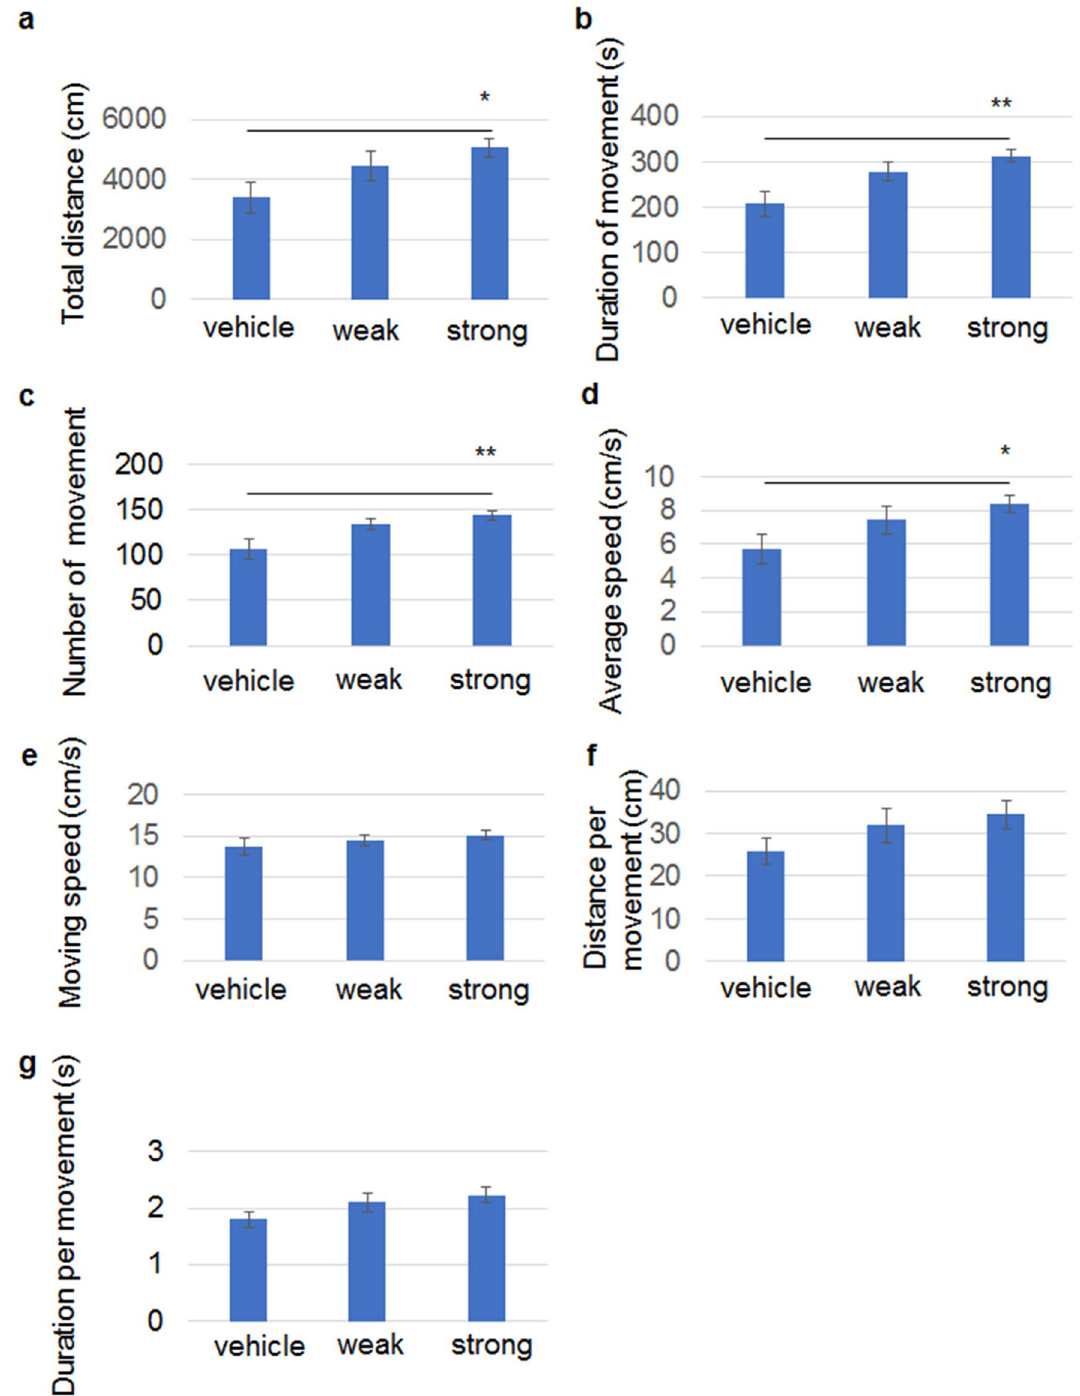
Figure 6. Strong aggregates of 13A increases spontaneous motor activities at 2 weeks of age. An open field test was conducted using 2-week-old mice that received an injection of the vehicle, weak aggregates, or strong aggregates at P2 (n = 14, each). The indices used were total walking distance ( a ), duration of movement ( b ), number of movement episode ( c ), average speed of locomotion over 10 min ( d ), moving speed ( e ), distance per movement ( f ) and duration per movement ( g ). Each error bar represents SE. ANOVA followed by post hoc test, *p < 0.05, **p <